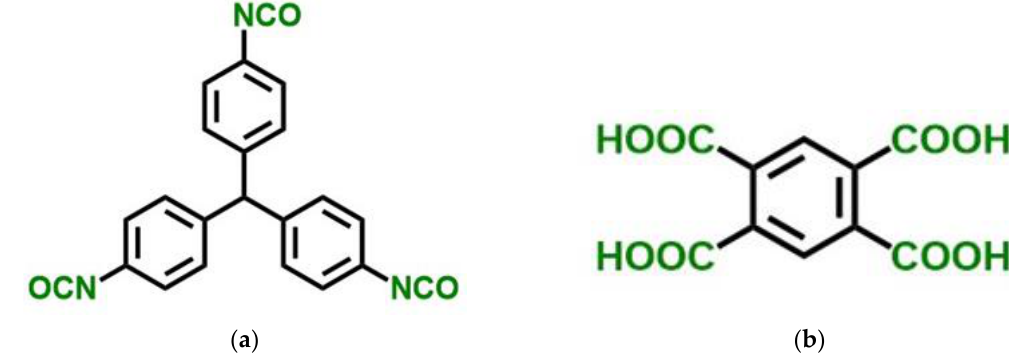
Figure 12. Structures of tris(4-isocyanatophenyl)methane (TIPM; Desmodur RE) ( a ) and pyromellitic acid (PMA) ( b ). Groups shown in green react according to Equation (2).